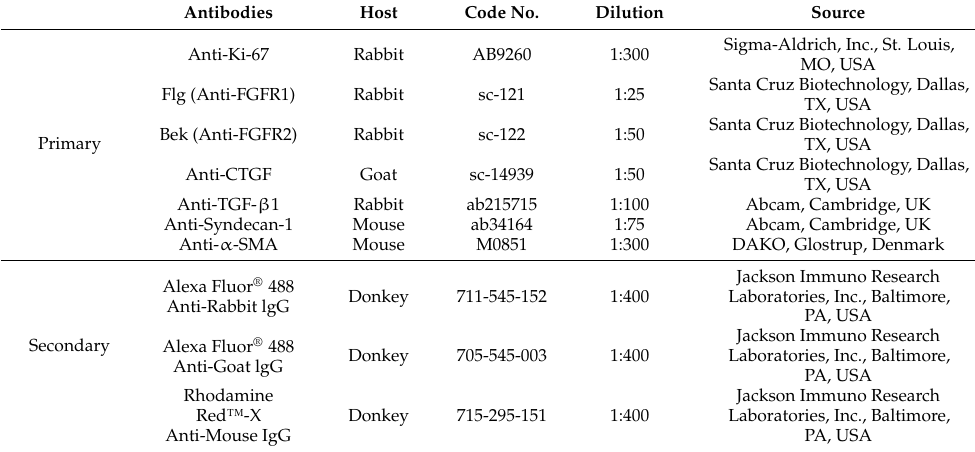
Table 1. Primary and secondary antibodies used in the study. Antibodies Host Code No.